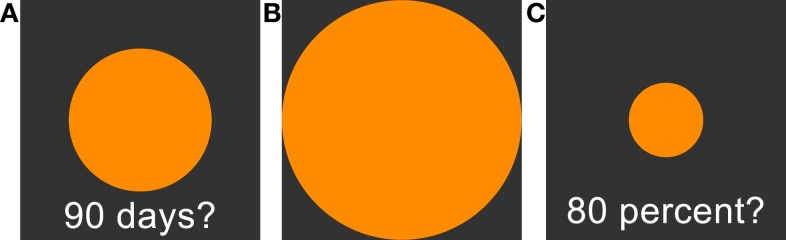
(A): Time perception task. Participants are asked to adjust the circle size in accordance to their estimation of subjective waiting time. Larger circles are indicating longer subjective waiting time. (B): 100% reference circle presented before the circle-size estimation task. (C): Circle-size estimation task. Participants are asked to adjust circle sizes in reference to the presented 100% reference circle (B). See Section “Materials and Methods” for further details.